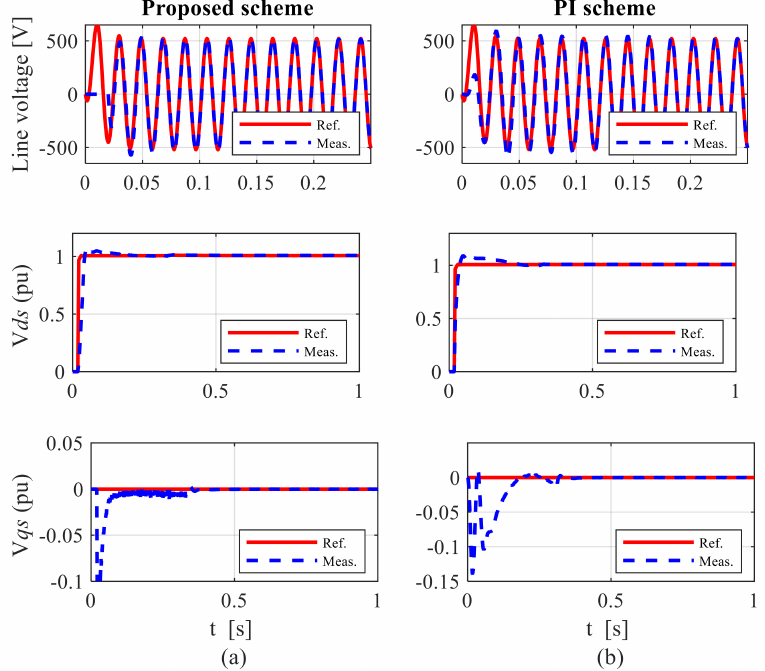
Figure 16. Control performances during sub-synchronous speed operation for f = 52 Hz: ( a ) proposed scheme and ( b ) PI